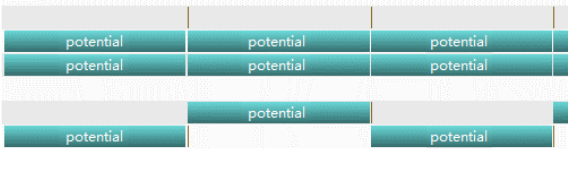
Fig. 8. The profile of stream scheduling on calculating the potentials.